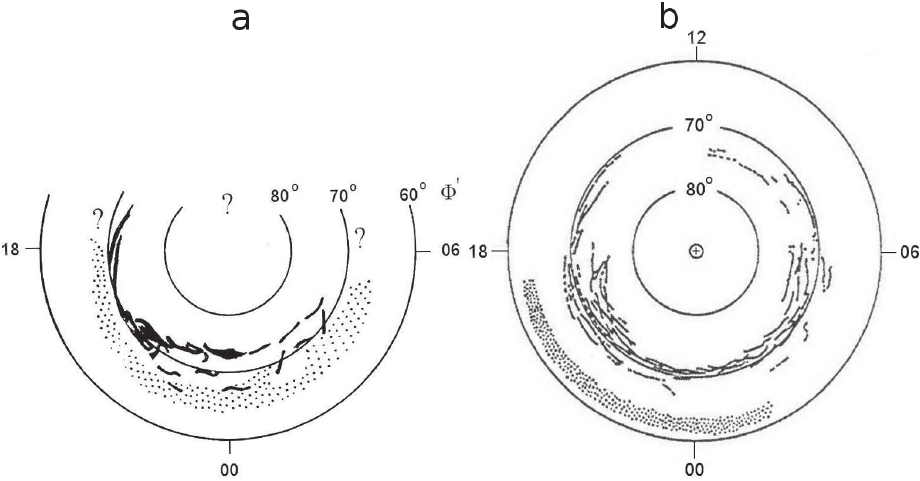
Figure 34. Distribution of discrete and diffuse auroras during the SMC periods. (a) Nighttime auroral pattern after Sergeev and Vorobjev (1979); (b) summary of the different auroral forms observed by all-sky cameras on 24 November 1981 (Yahnin et al.,